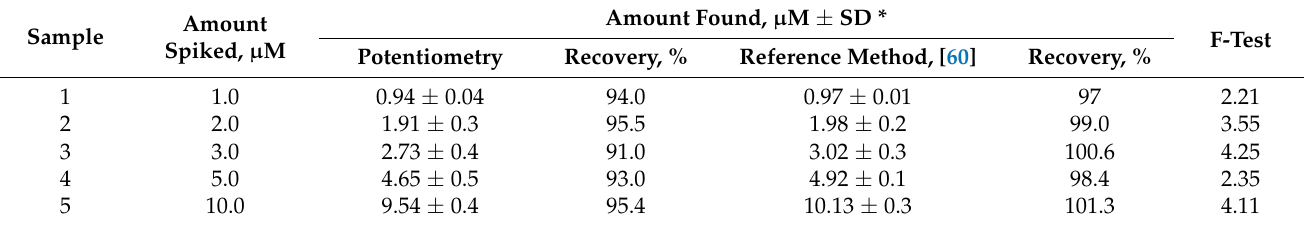
Table 2. Determination of PHO in spiked serum